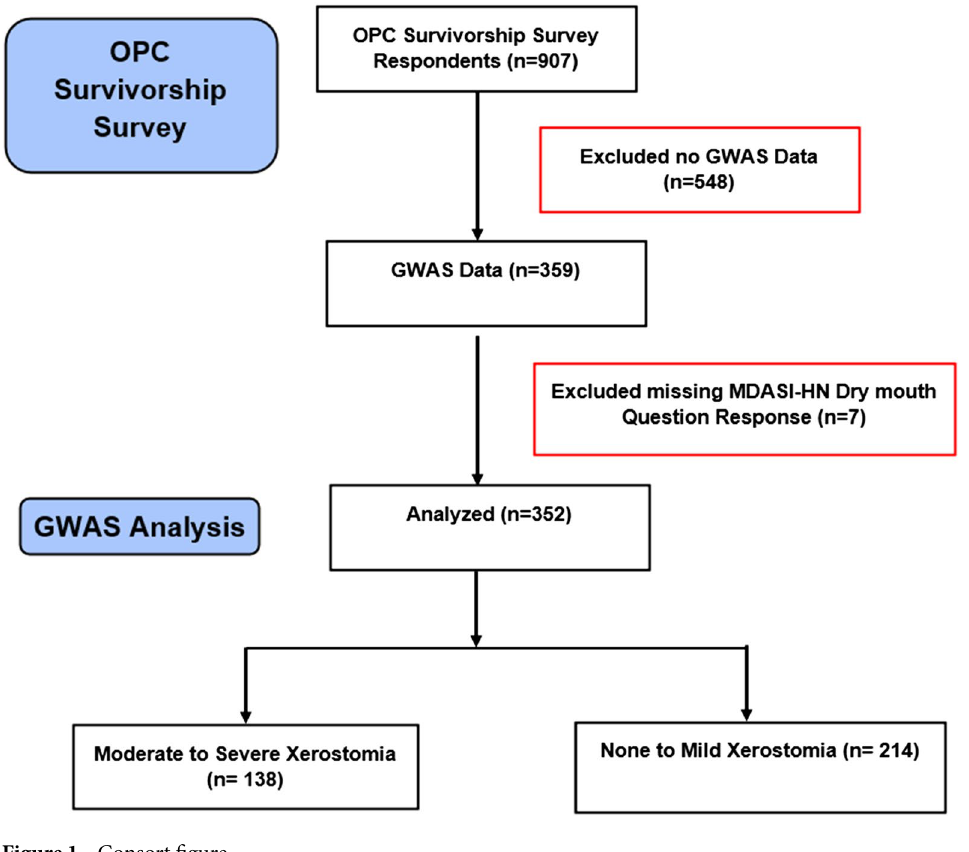
Figure 1. Consort